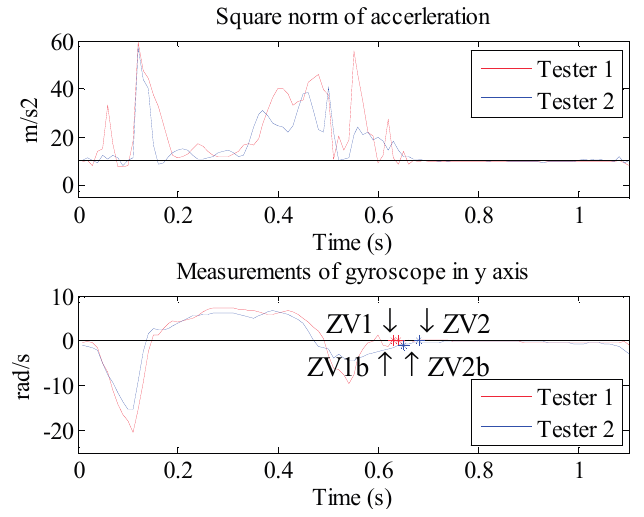
Figure 10. The square norm of acceleration and the gyroscope measurements in the y